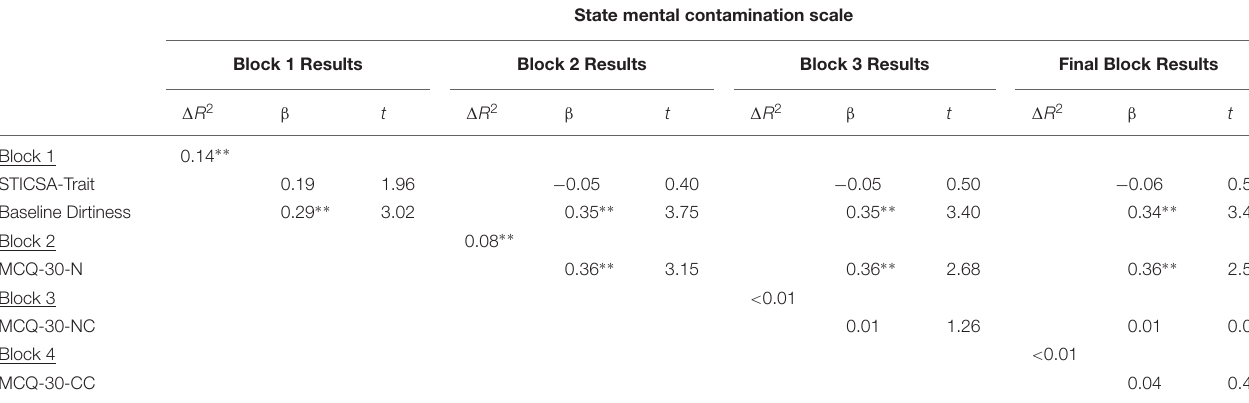
TABLE 2 | Hierarchical regression results examining predictors of mental contamination severity following evoking